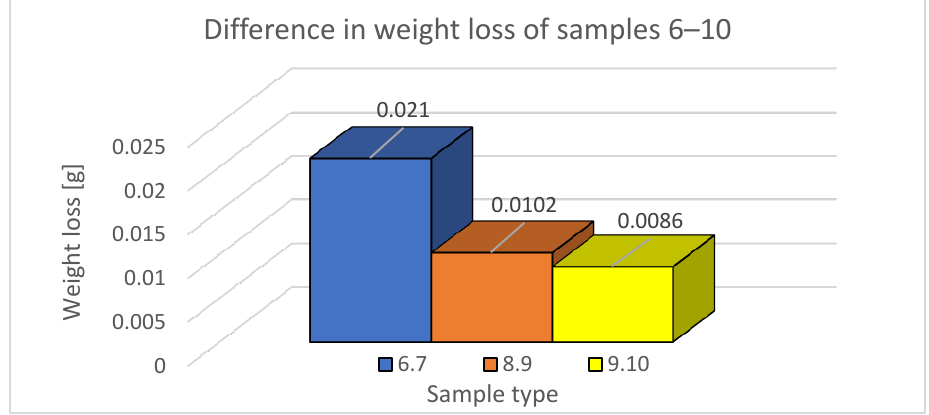
Figure 9. Difference in weight loss in Samples 6 – 10, represented graphically. Table 9. Weight differences in samples 6 – 11 (g).